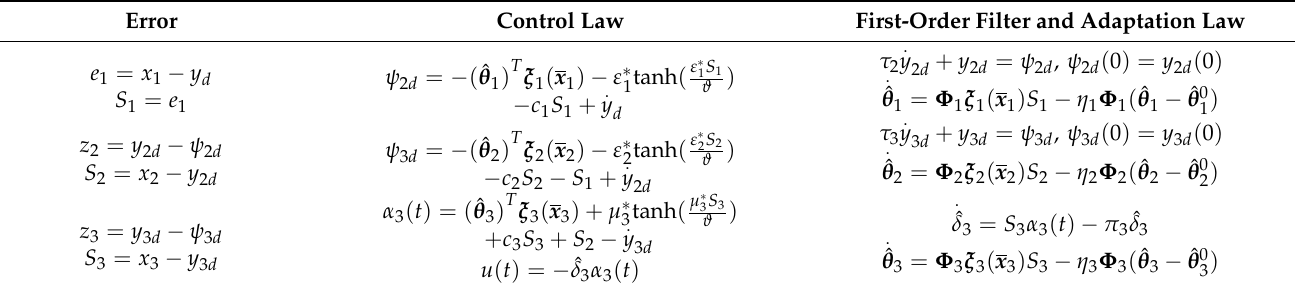
Table 1. Intermediate control signals and control